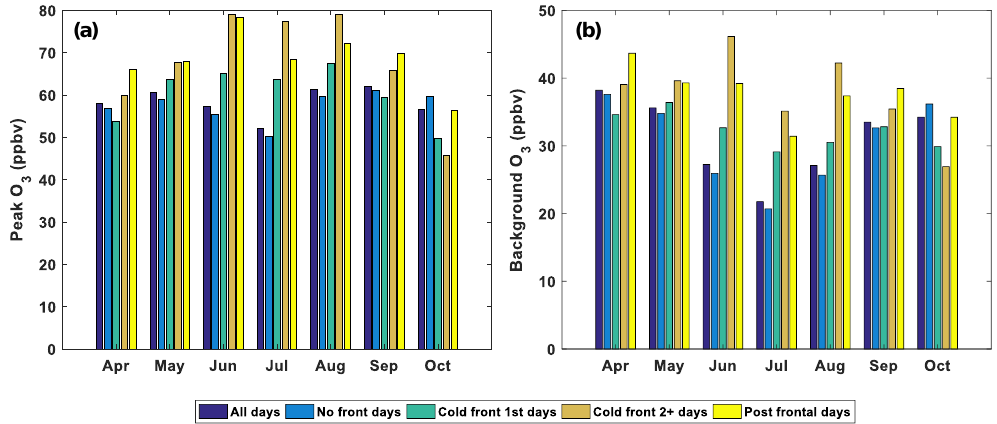
Figure 6. Monthly time series of average ( a ) peak O 3 and ( b ) background O 3 mixing